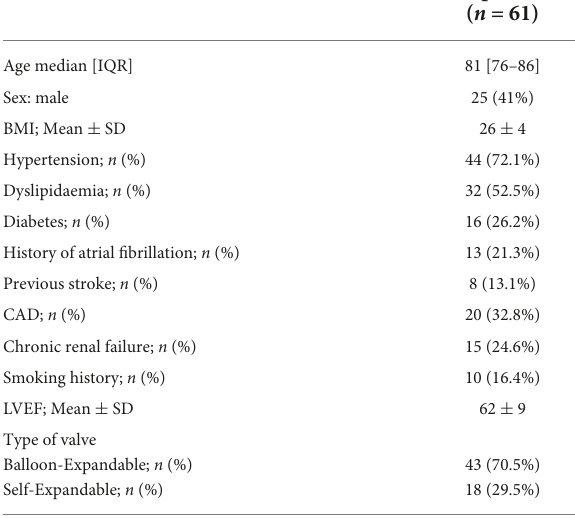
TABLE 1 General characteristics and medical